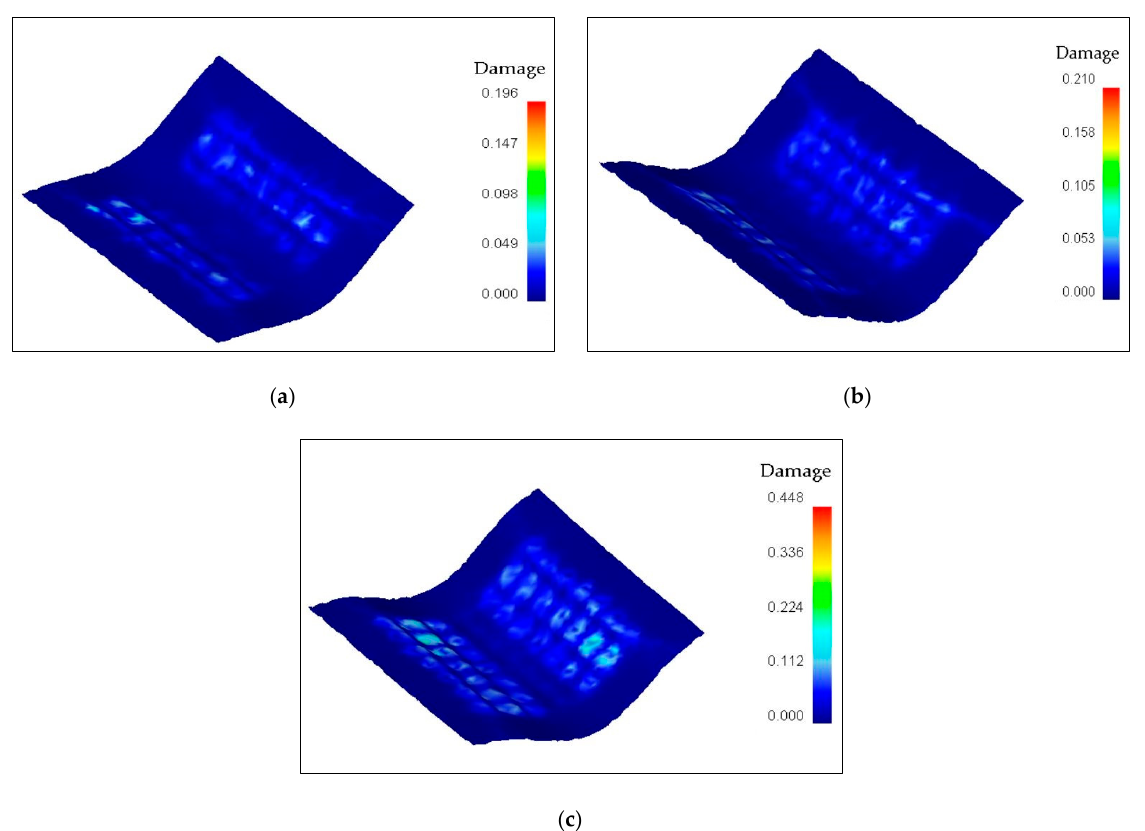
Figure 11. Damage factors of form1 with ( a ) 10 mm pins; ( b ) 12 mm pins; ( c ) 14 mm pins.